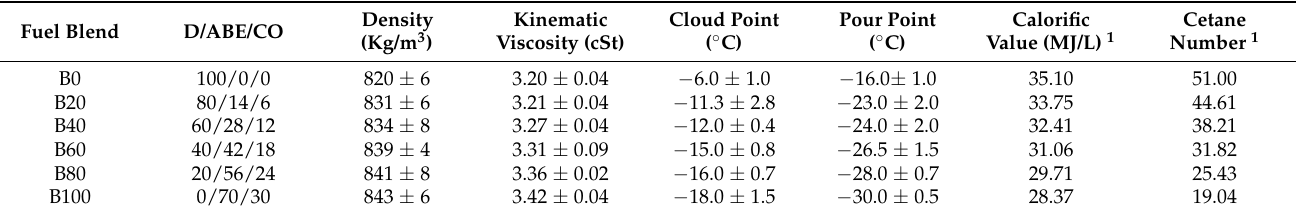
Table 6. Viscosity values at 40 ◦ C (cSt, centistokes), density, cloud point, pour point, calorific value, and cetane number of the diesel/ABE/castor oil blends, obtained by adding different amounts of ABE/castor oil double blend, containing 70% ABE, to diesel. Errors are always calculated as standard deviation from the average of three